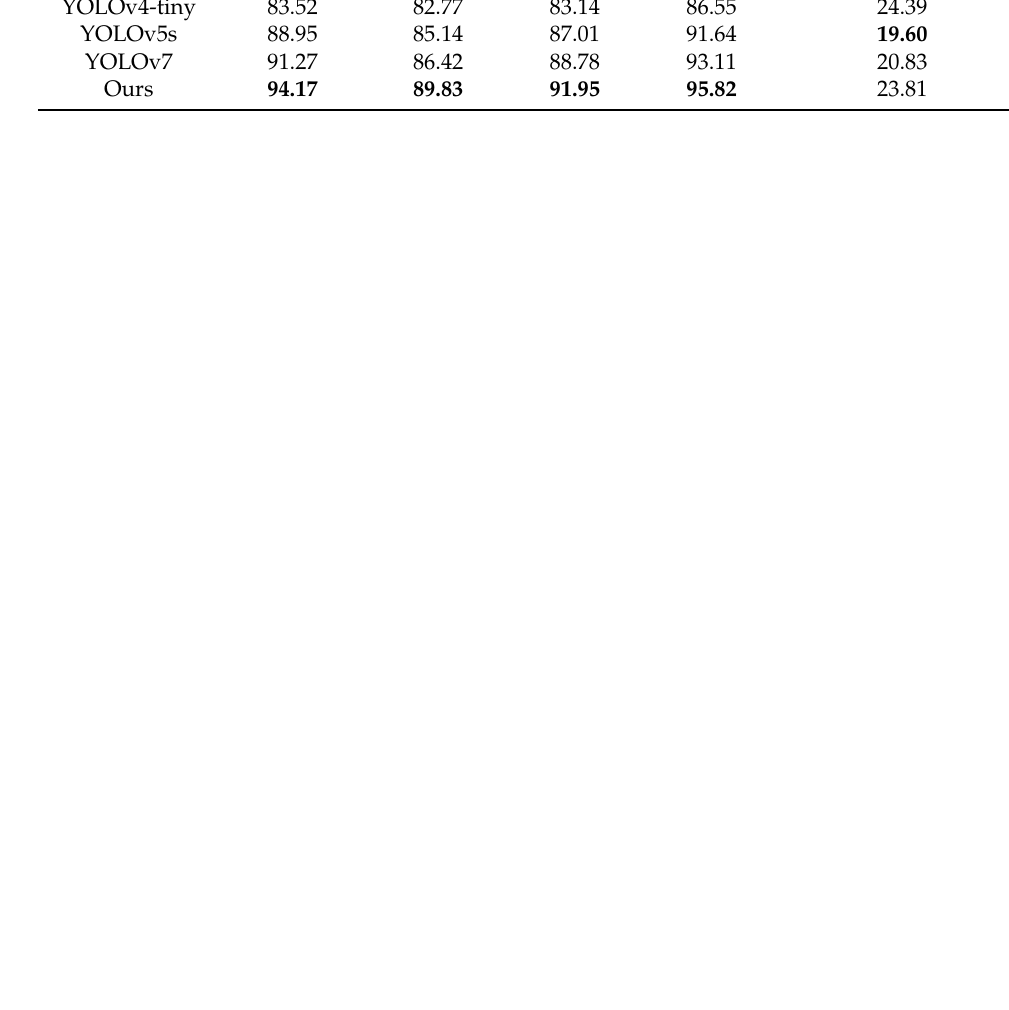
Table 4. Comparison of the proposed network with the other networks.